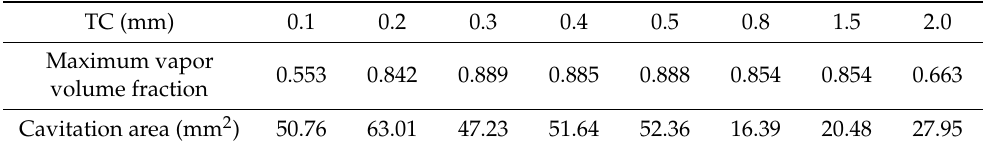
Figure 10. Vapor volume fraction distribution in the passage between blades. Table 2. Maximum Vapor Volume Fraction and Cavitation Table 2. Maximum Vapor Volume Fraction and Cavitation Area.